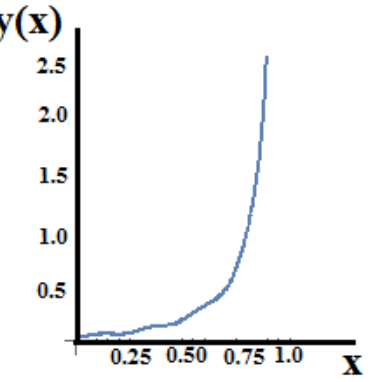
Figure 20. The displacement field y ( x ) in the initial space.